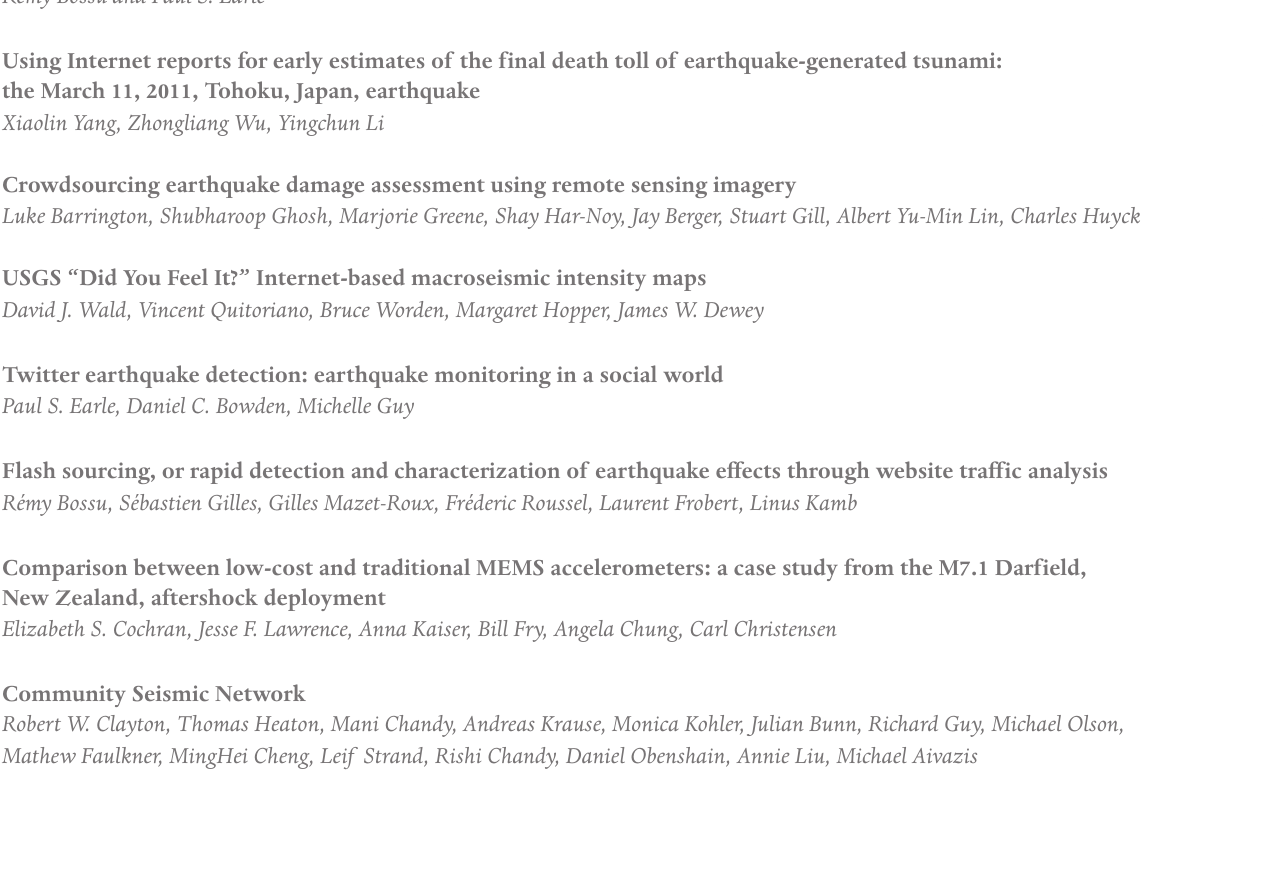
On the use of the Internet to collect earthquake information Rémy Bossu and Paul S.